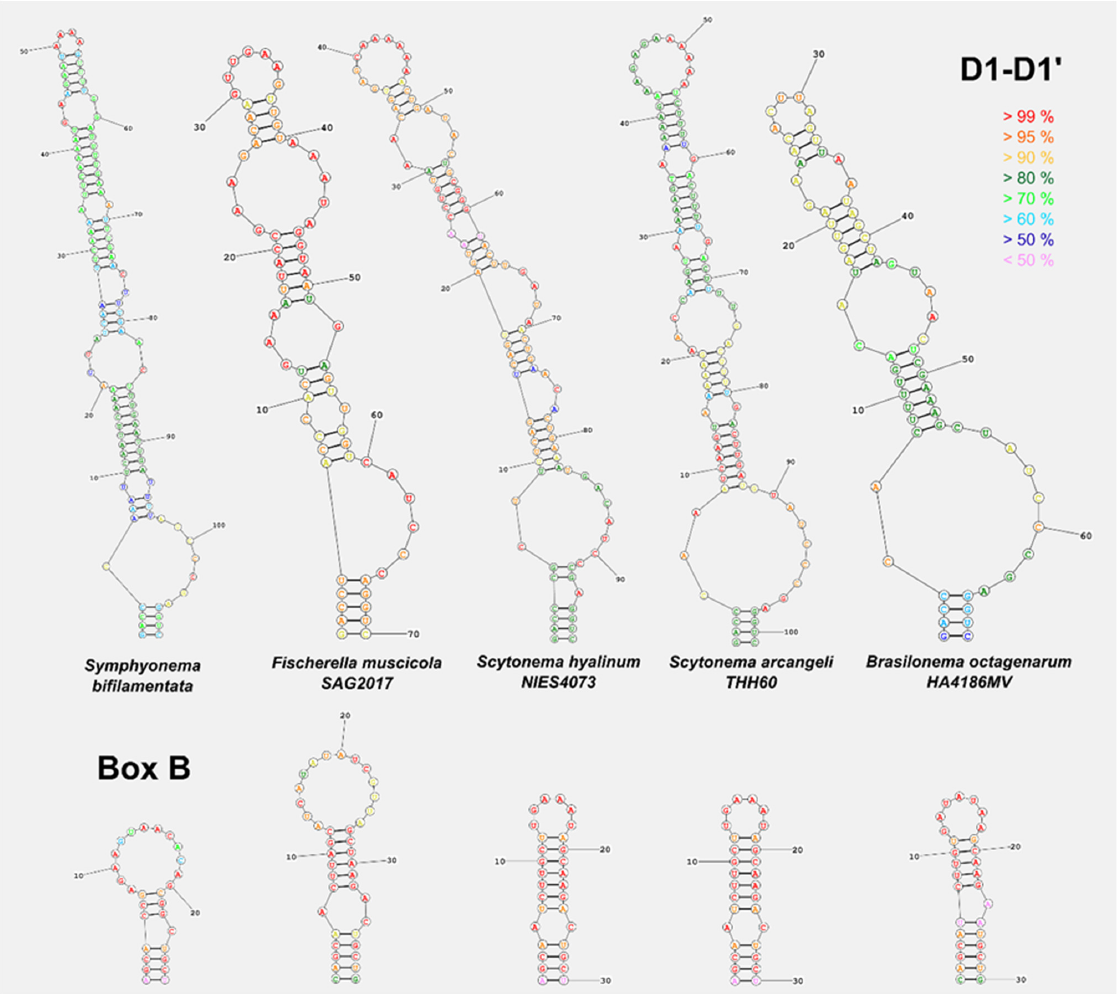
Figure 4. Predicted secondary RNA structures of the main informative helices of the 16S-23S ITS region (D1-D1 ′ and Box B) of Symphyonema bifilamentata sp. nov. 97.28 in comparison with the closest strains in terms of phylogenetic position and morphology. Color code indicates the probability in percent of the calculated base position.